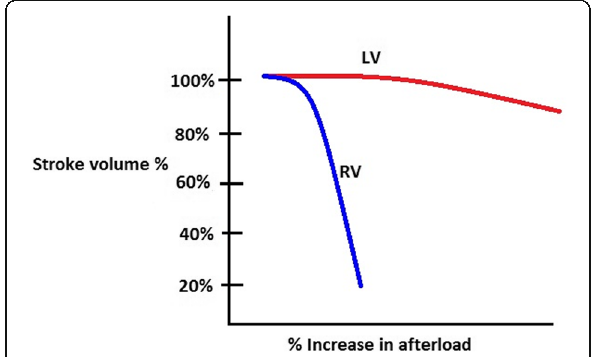
Fig. 3 Relationship of afterload and stroke volume. Right ventricular (red) stroke volume response to increases in afterload is devastating compared to the left ventricular (blue) stroke volume response which is more